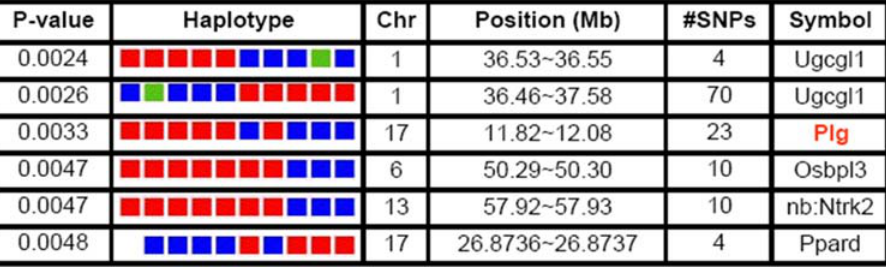
Figure 2. Computational genetic analysis identifies plasminogen ( PLG ) as a candidate susceptibility gene for invasive aspergillosis. Haplotype-based computational genetic analysis was used to analyze the area under the survival curve to identify genetic factors affecting survival after AF exposure among the inbred strains. Colored blocks represent haplotype structure, with red blocks representing ‘‘resistant’’ murine strains (C57, 129, Balb/C, Balb/CBy and AKR) and the ‘‘intermediate’’ strain NZW/LacJ and blue blocks representing ‘‘susceptible’’ murine strains (A/J, DBA/2J and C3H/HeJ) and the ‘‘intermediate’’ strain MR/MpJ. The green block represents missing haplotype data.